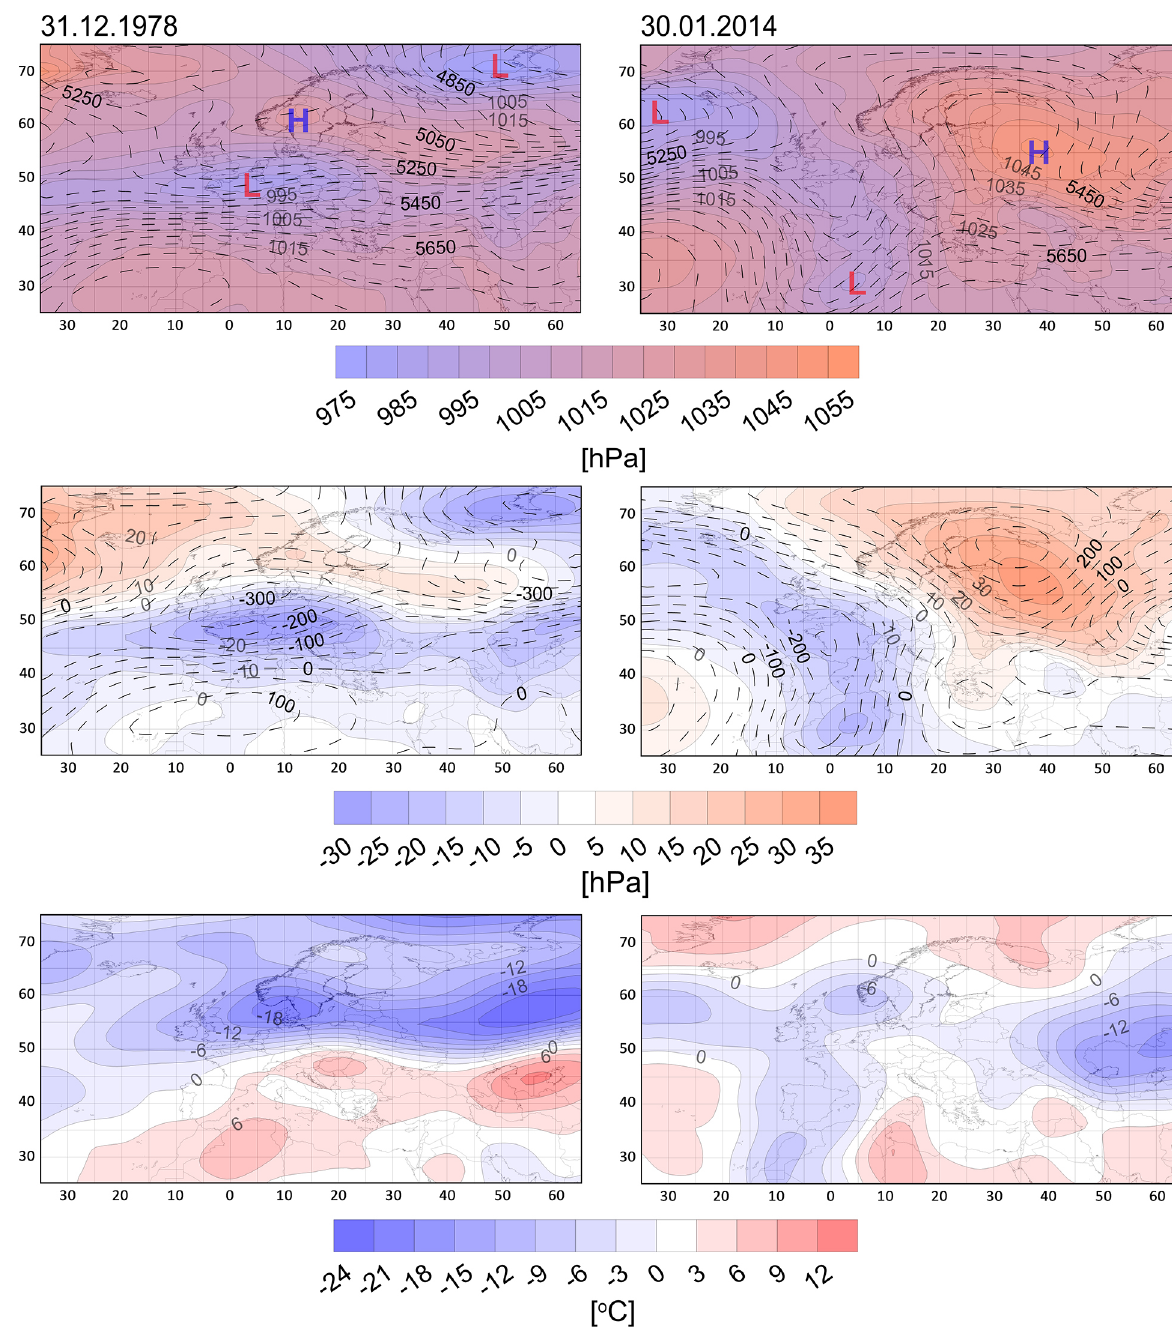
Fig. 7. Mean SLP [in hPa] (colour scale) and z500 hPa [in gpm] (dotted line) (top row); SLP [in hPa] (colour scale) and z500 hPa anomalies [in m] (dotted line) (middle row); and anomalies of T850 [in °C] (bottom row) for the selected days. SLP, sea level